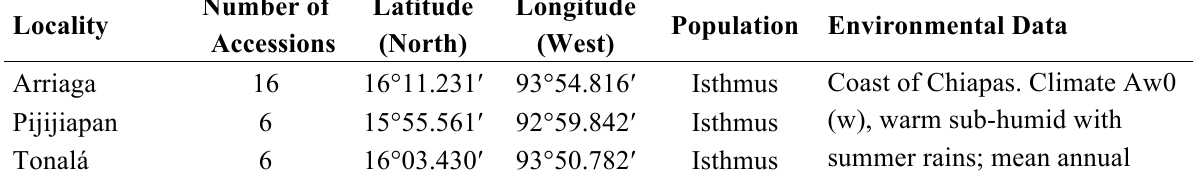
Table 1. Jatropha curcas L. accessions collected in the state of Chiapas located in the Germplasm Bank of the Center for Biosciences, University of Chiapas,